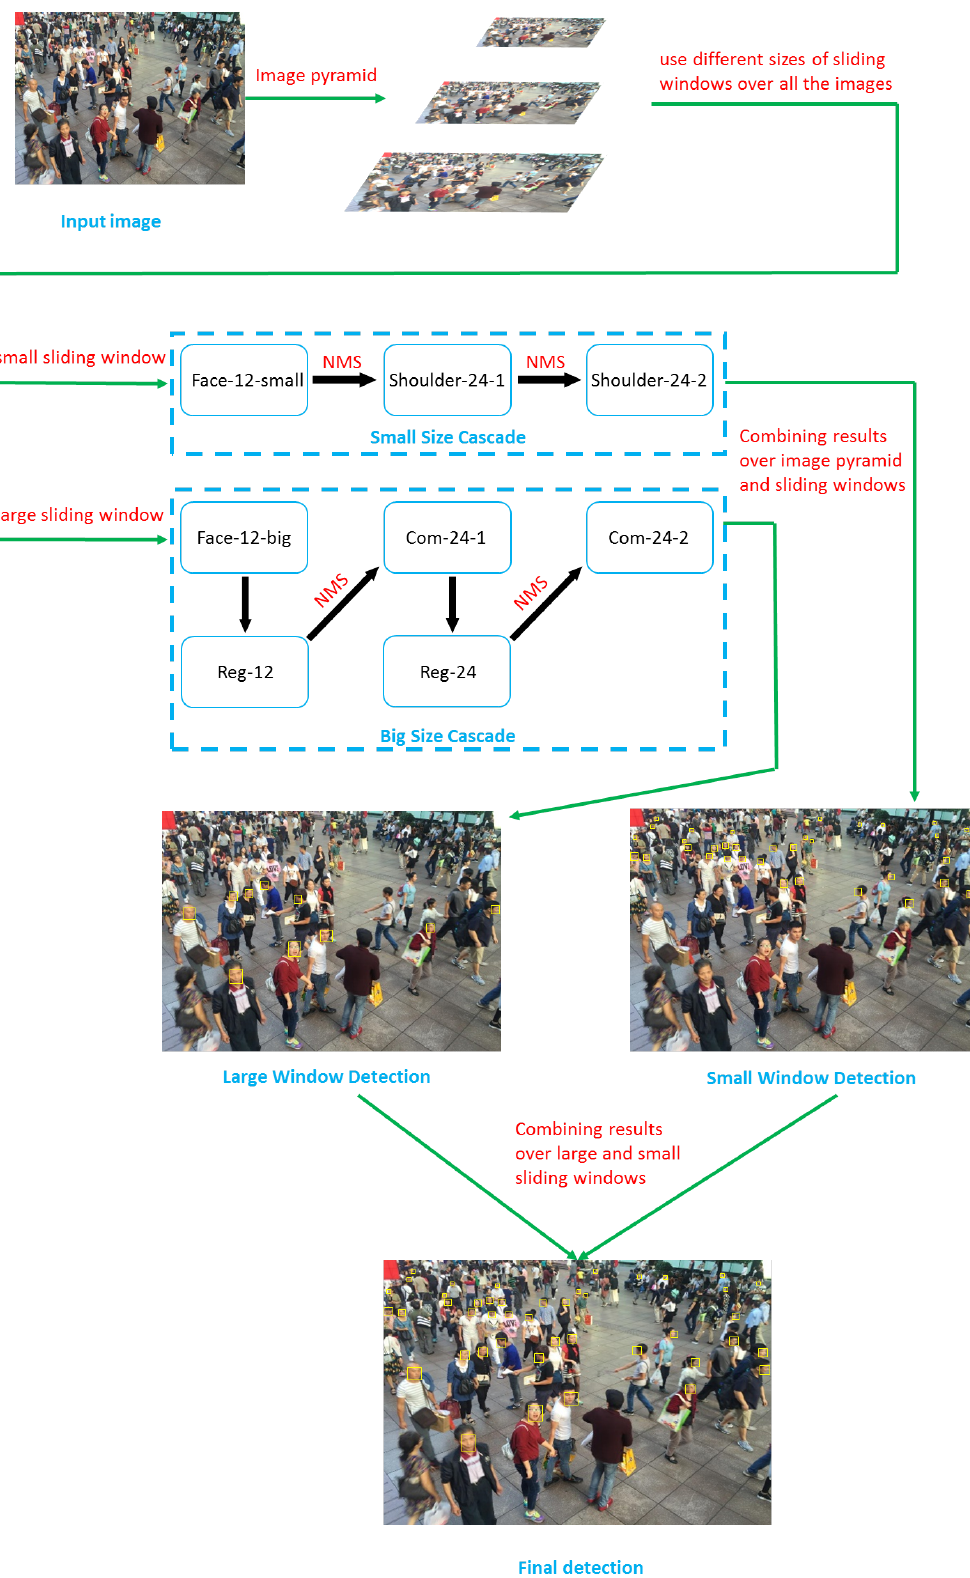
Figure 2. The overall framework of our proposed face detection algorithm, which consists of two parallel CNN cascaded networks for detecting different scales of faces. NMS, non-maximum suppression; Reg,